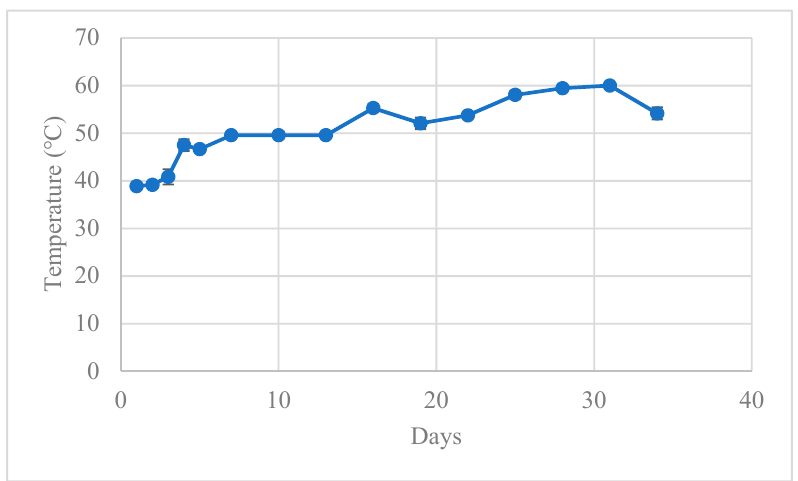
Figure 2. Temperature and standard error from the four temperature probes situated within the compost pile over 33 days, starting from the day of pile creation (Day 0) to the use of the pile on the field as fertilizer (Day